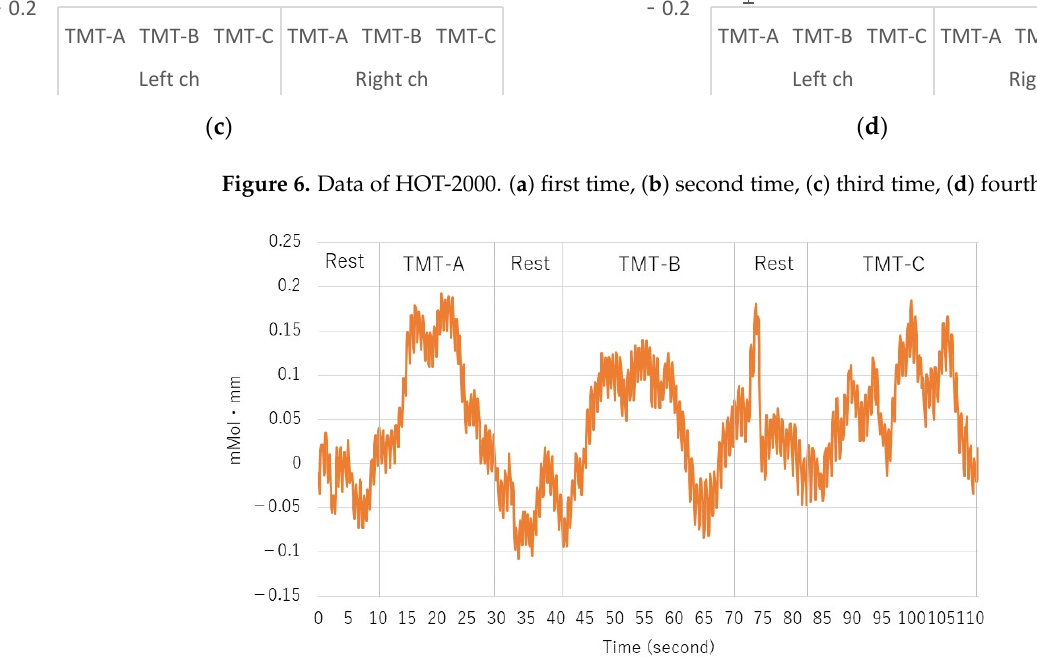
Figure 7. One example of a curve for the signal.